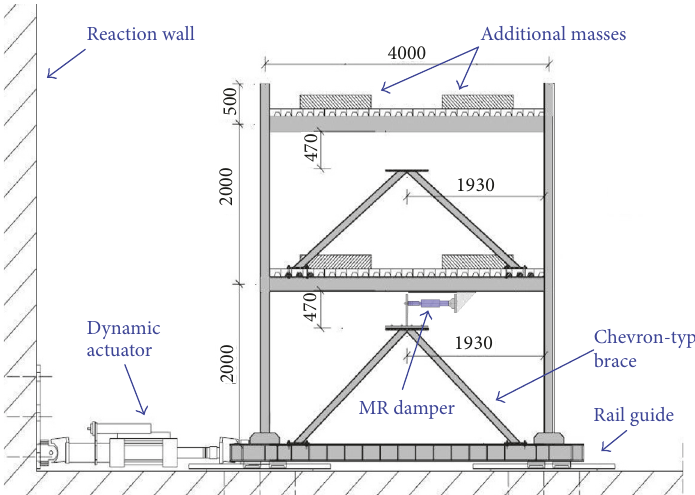
Figure 1: Experimental setup (dimensions in